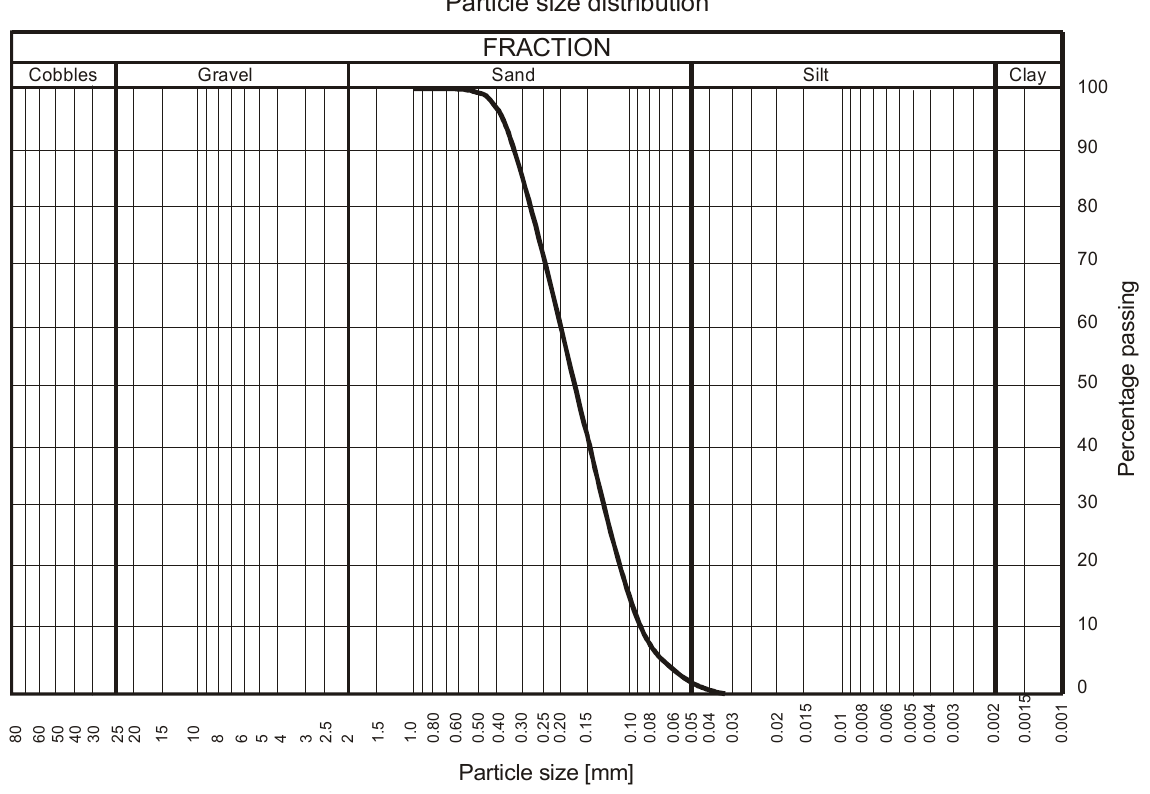
Figure 4. Grain size distribution curve of the material used as backfill.